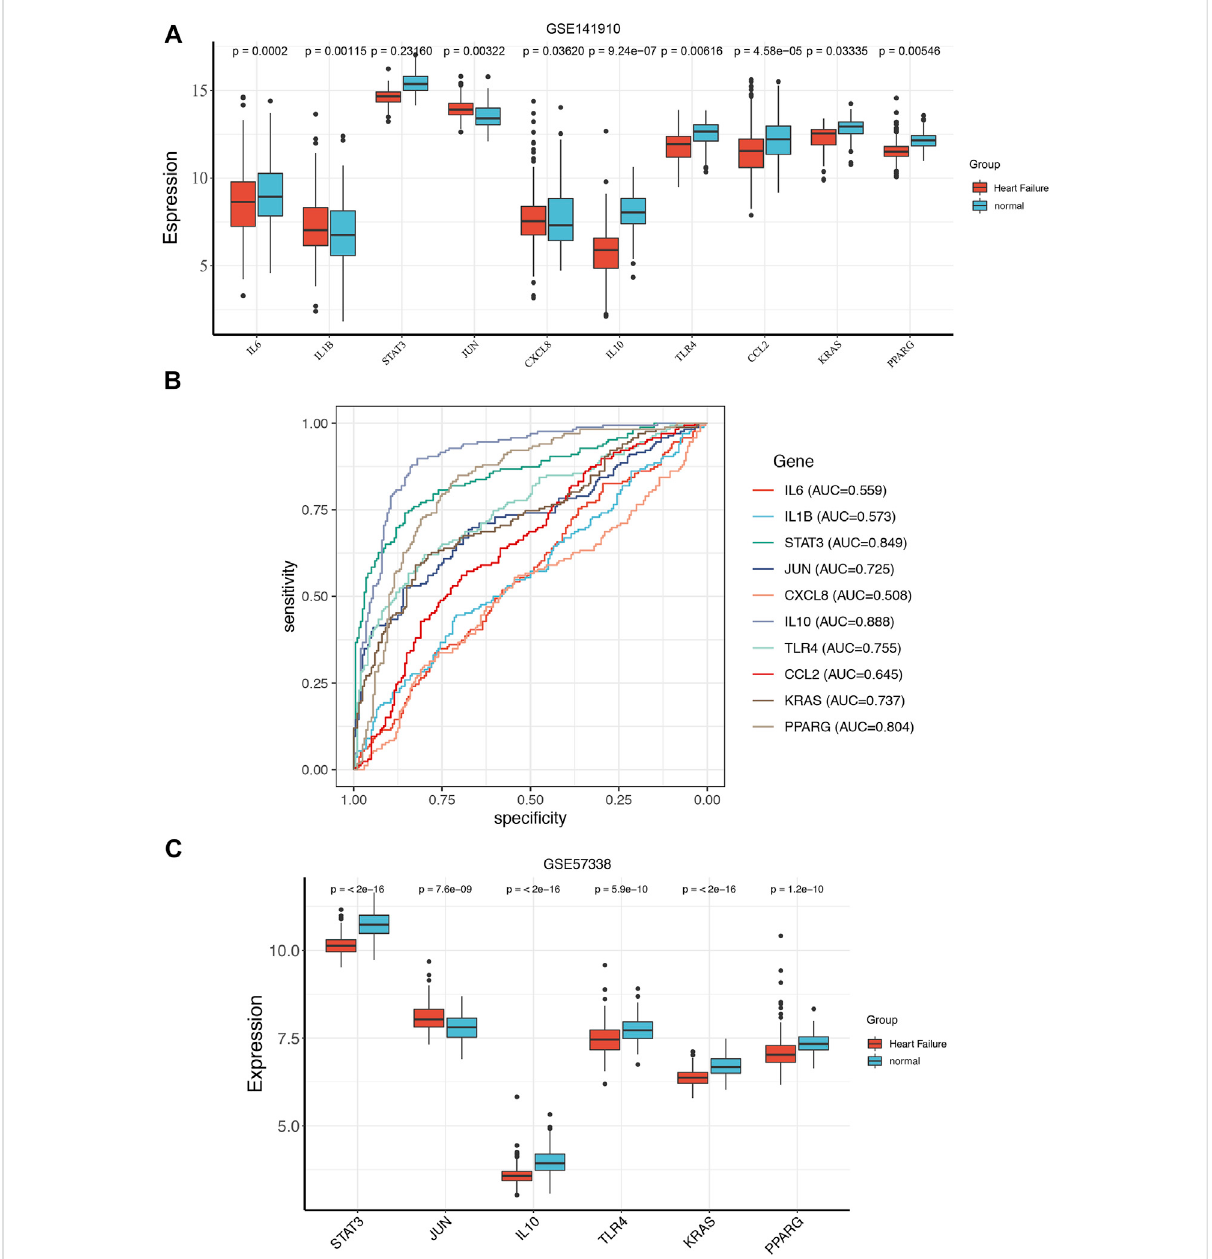
FIGURE 3 TheROCcurveanalysisandexpressionanalysisofhubgenesintrainsetandvalidationset.TheexpressionofthehubgenesbetweentheHFand normal group in GSE141910 (A) . ROC curve evaluated the diagnostic value of hub genes for HF in GSE141910 (B) . The expression of the hub genes between the HF and normal group in GSE57338 (C)